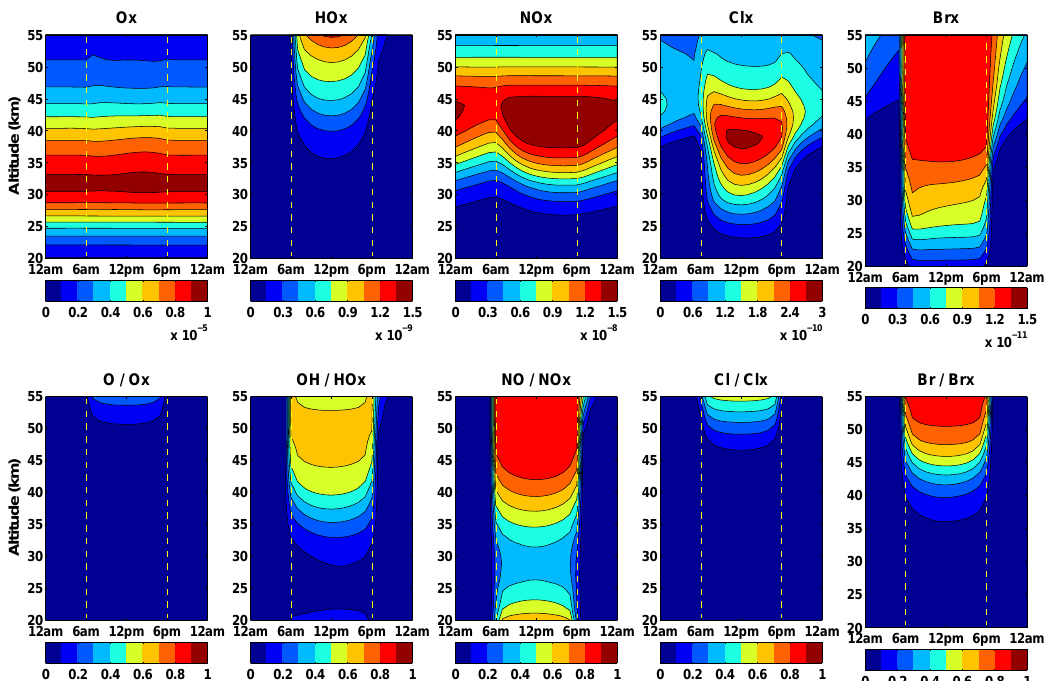
Fig. 2. Diurnal cycle of the relevant chemical families and their partitioning ratio on day 5 of the solar average simulation. Chemical families are shown in units of volume mixing ratio. Vertical yellow dashed lines show the sunrise and sunset times, 06:00a.m. and 06:00p.m.,